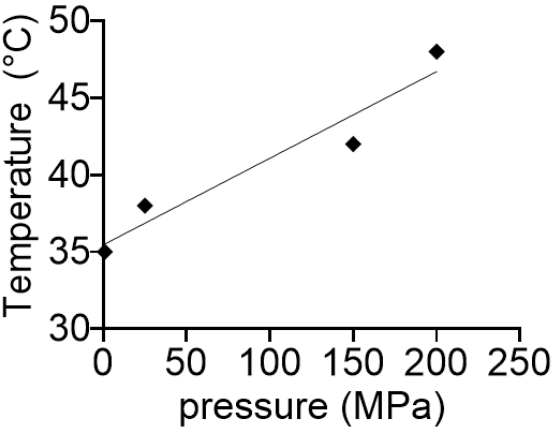
Figure 9. Reciprocal compensatory effects of pressure and temperature in the ASBVd( − ) autocatalytic reaction. The plot was determined by estimating the temperature required at each pressure to achieve a 5% cleavage of the viroid in 1 min.